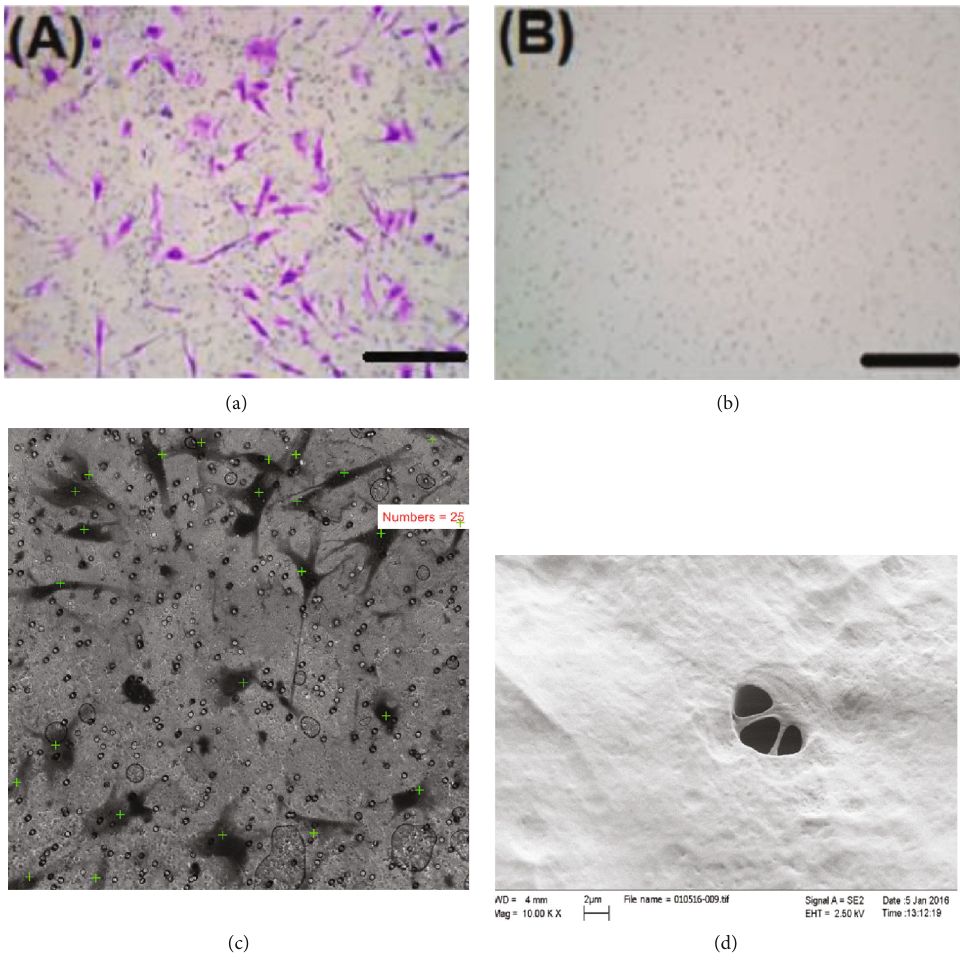
Figure 4: (a) Representative images of 8 μ m perforated polycarbonate membranes with migrated cells in the lower compartment of membrane when bovine serum was used as a chemoattractant (cells stained with crystal violet; 10,000 cells seeded in the upper compartment). (b) Lower side of the membrane in the serum-free control group, showing no cells migrated. (c) Cells counted in the lower compartment in 5 random fi elds, 40x magni fi cation (serum group). (d) SEM image of GMSCs aggregating over 8 microns pores of perforated polycarbonate membrane, with a cell process still inside one of the membrane